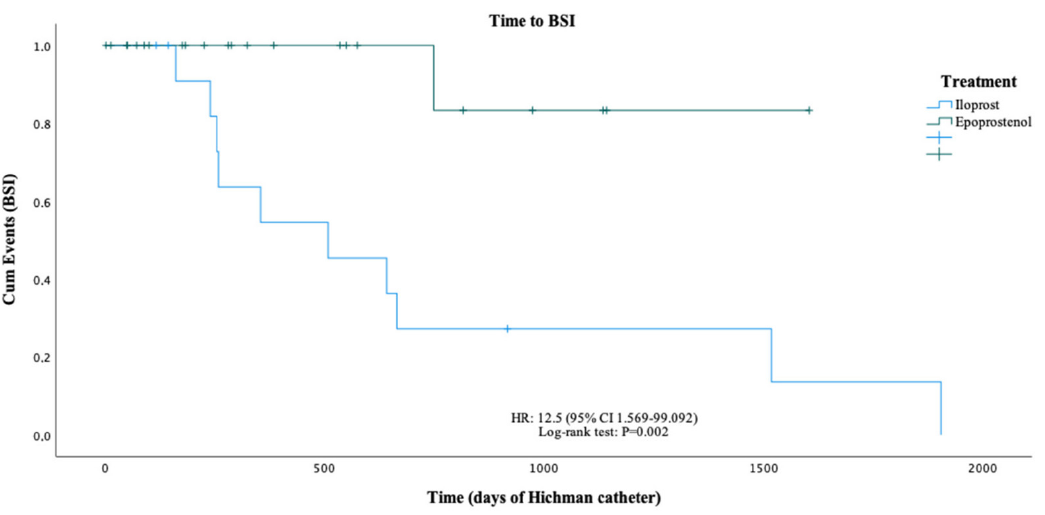
Figure 1. Analysis of BSI occurrence in PH patients treated with intravenous epoprostenol or intra- venous iloprost.